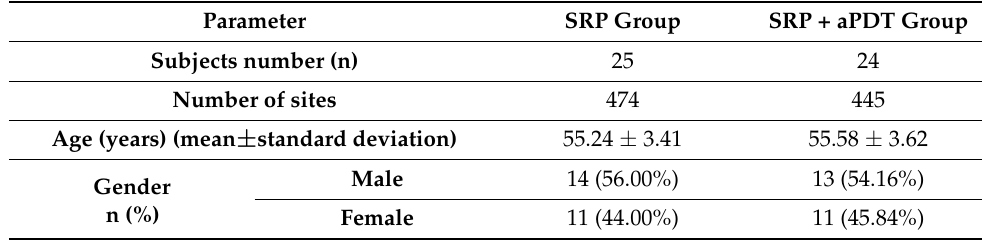
Table 1. Demographic parameters for study groups at baseline and after 6